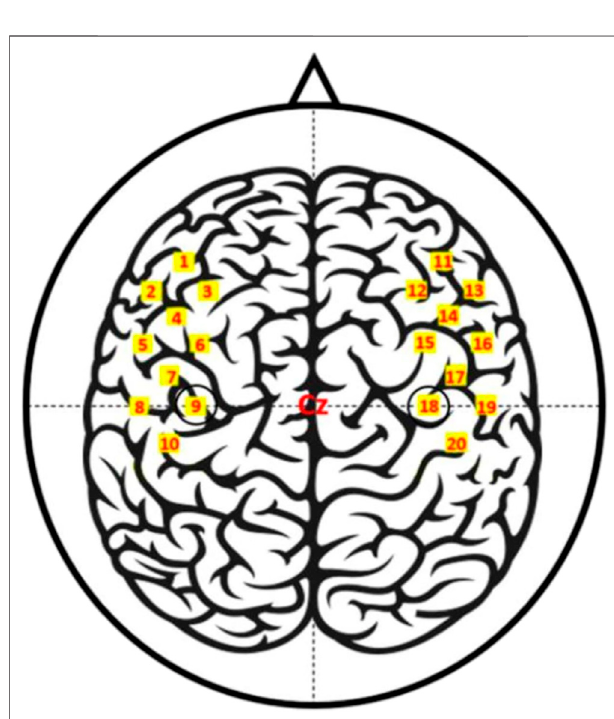
FIGURE 3 | fNIRS channel locations (Bak et al., 2019).